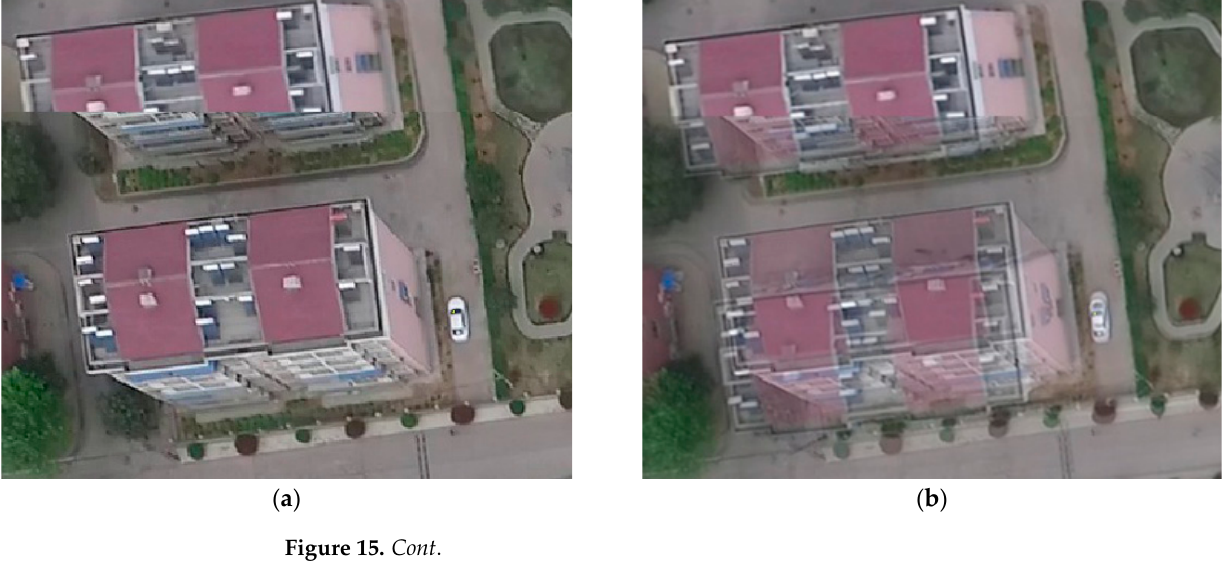
( d ) Figure 15. Compositing comparison of house in panorama using di ff erent fusion methods. ( a ) Simple coverage. ( b ) Weighted fusion. ( c ) Weight substitution. ( d ) Our method. 3.4.7. Comparison with Other UAV Mosaicking Algorithms In our experiments, we compared QuickBird [35] and AutoPano [36], two pieces of well-established commercial stitching software, with Opencv-Stitcher, an advanced stitching algorithm. Our experiments were conducted on the Phantom3-village, and the results of each algorithm are presented in Figure 16. Additionally, Figure 17 displays the details of the roads, while Figure 18 highlights the details of the houses. In order to compare the e ffi ciency of the algorithm, we recorded the algorithm time consumed, which can be seen in Table 9. Table 9. Comparison of time consuming. QuickBird